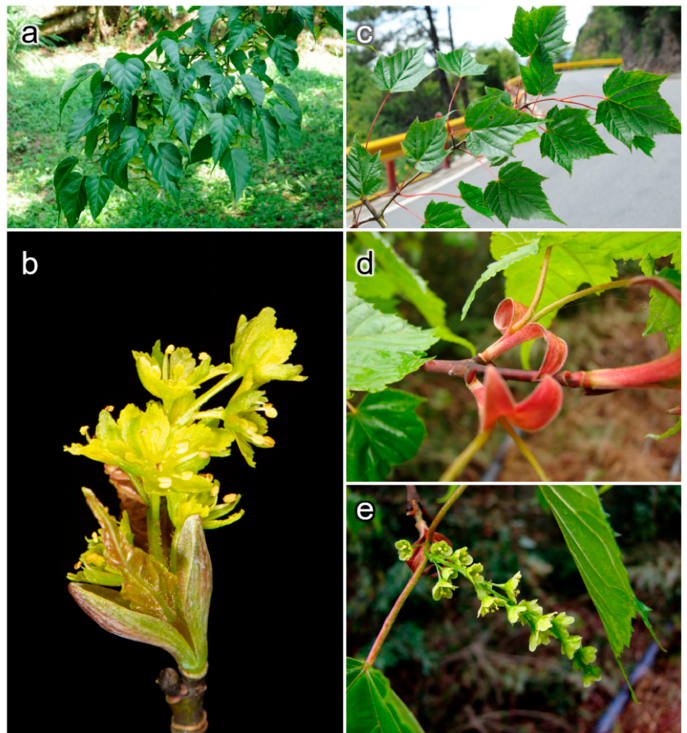
Figure 1. Leaf and floral morphology of Acer caudatifolium and A. morrisonense . ( a , b ) are the leaves and inflorescence of A. caudatifolium , respectively. ( c – e ) are the leaves, red stipules, and inflorescence of A. morrisonense , respectively. These two species have diagnostic characters of three-lobed vs. five-lobed leaves, yellowish green vs. red stipules, and short vs. long inflorescences between A. caudatifolium and A. morrisonense .